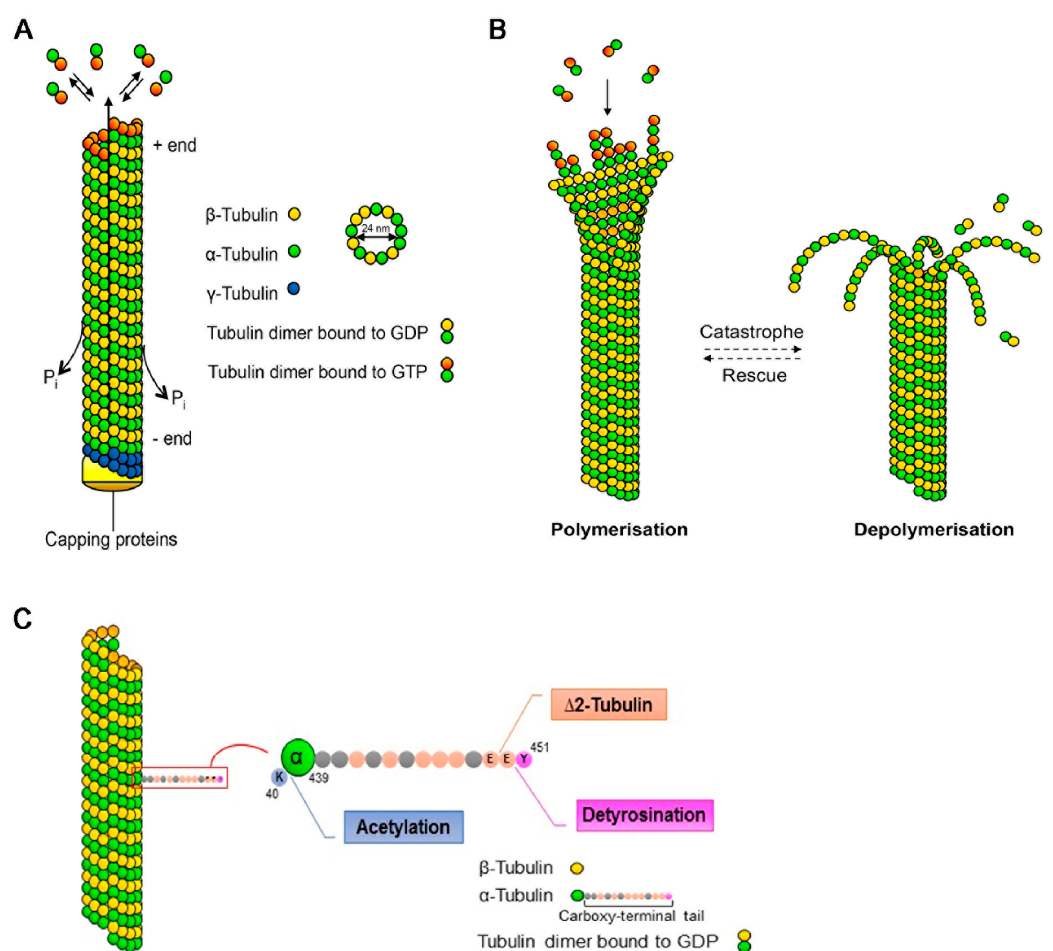
Figure 1. Microtubule dynamics and post-translational modifications. ( A ) Microtubules (MTs) are composed of α - and β -tubulin heterodimers that assemble to linear proto-filaments that associate laterally, forming the hollow MT cylinder. Assembly, which is nucleated from the γ -tubulin ring, occurs in a polarised fashion with the β -tubulin subunit oriented towards the growing plus-end. Newly-incorporated tubulin is bound to guanosine triphosphate (GTP) that gets rapidly hydrolysed upon polymerisation, generating guanosine diphosphate (GDP)-bound tubulin along the MT lattice. ( B ) MTs are dynamic structures undergoing cycles of growth (polymerisation) and shrinkage (depolymerisation). The switch from growth to shrinkage is termed catastrophe, whereas rescue indicates the switch from shrinkage to growth. ( C ) The α -tubulin subunit can be acetylated on lysine (K) 40, which is located on the inner side of the MT. The C-terminal tail of α -tubulin projects away from the MT lattice and undergoes various post-translational modifications. The extreme tyrosine residue (Y) can be enzymatically removed, generating detyrosinated α -tubulin, which normally correlates with long-lived MTs. Further removal of the penultimate glutamate (E) generates ∆ 2-tubulin.